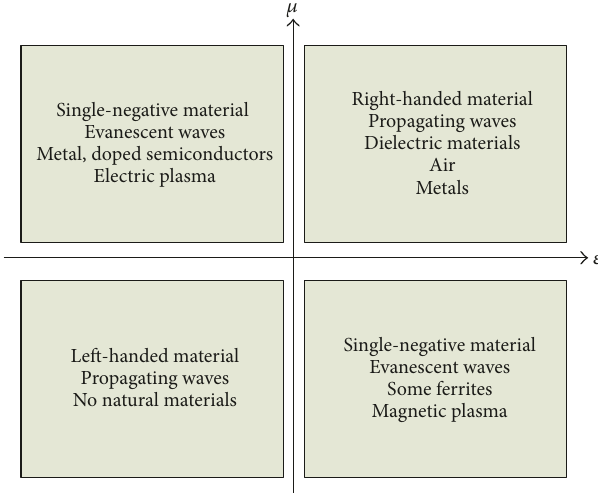
Figure 3: Classification of media according to permittivity and permeability [15, 94,